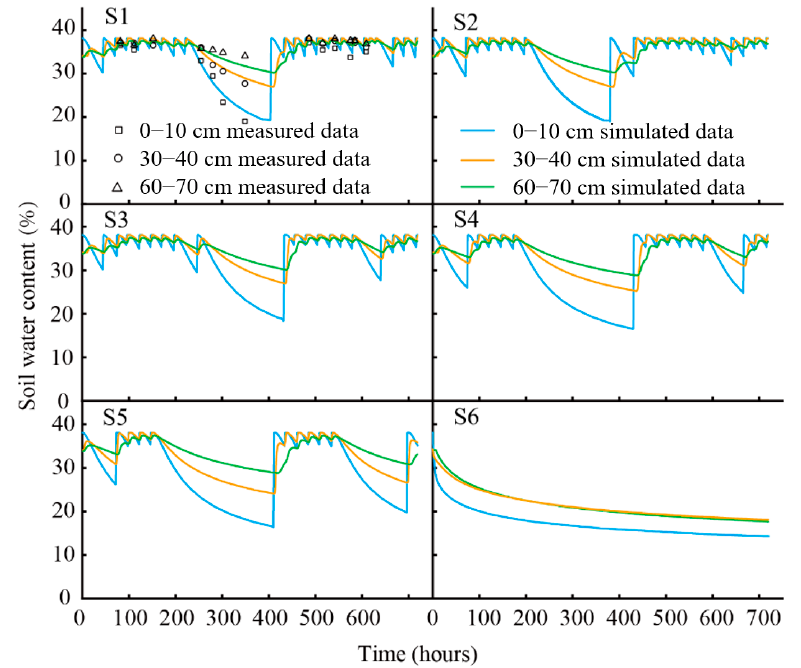
Figure 8. The variation of soil water contents in each scenario S1–S6.